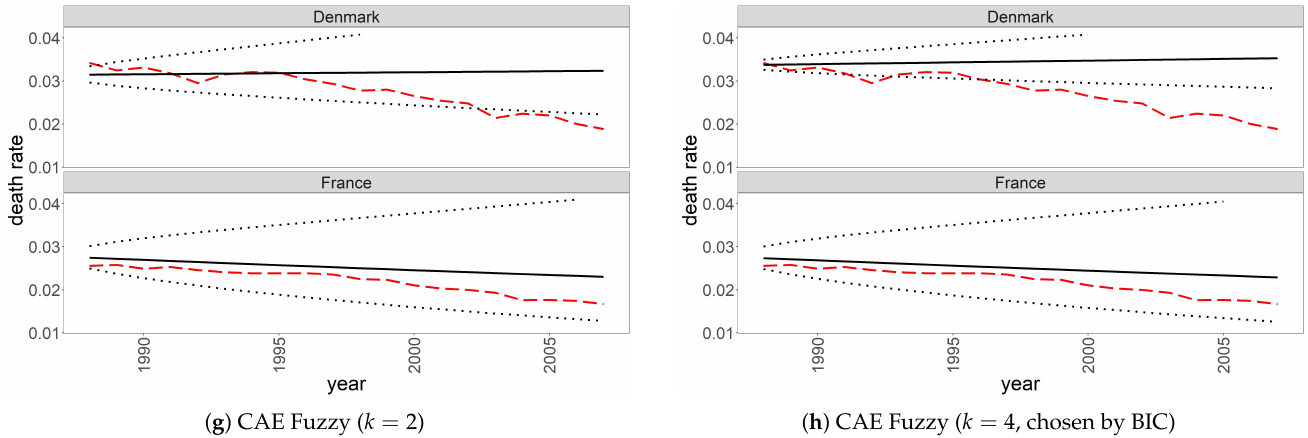
Figure 6. Actual (red, dashed) and forecast (black, solid) central death rates and 95% prediction intervals (black, dotted) for males aged 67 in Denmark and France (models calibrated on 10 countries) between 1988 and